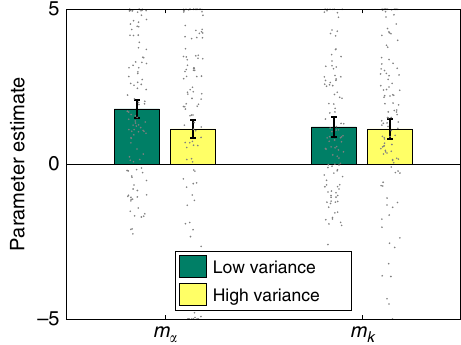
Fig. 4 Experiment results. Magnitude scaling parameter estimates for the three-parameter hyperbolic discounting model (H3), aggregated separately for low and high variance conditions. n = 221 participants. Data are presented as mean values, dots denote individual subjects, and error bars show 95% con fi dence